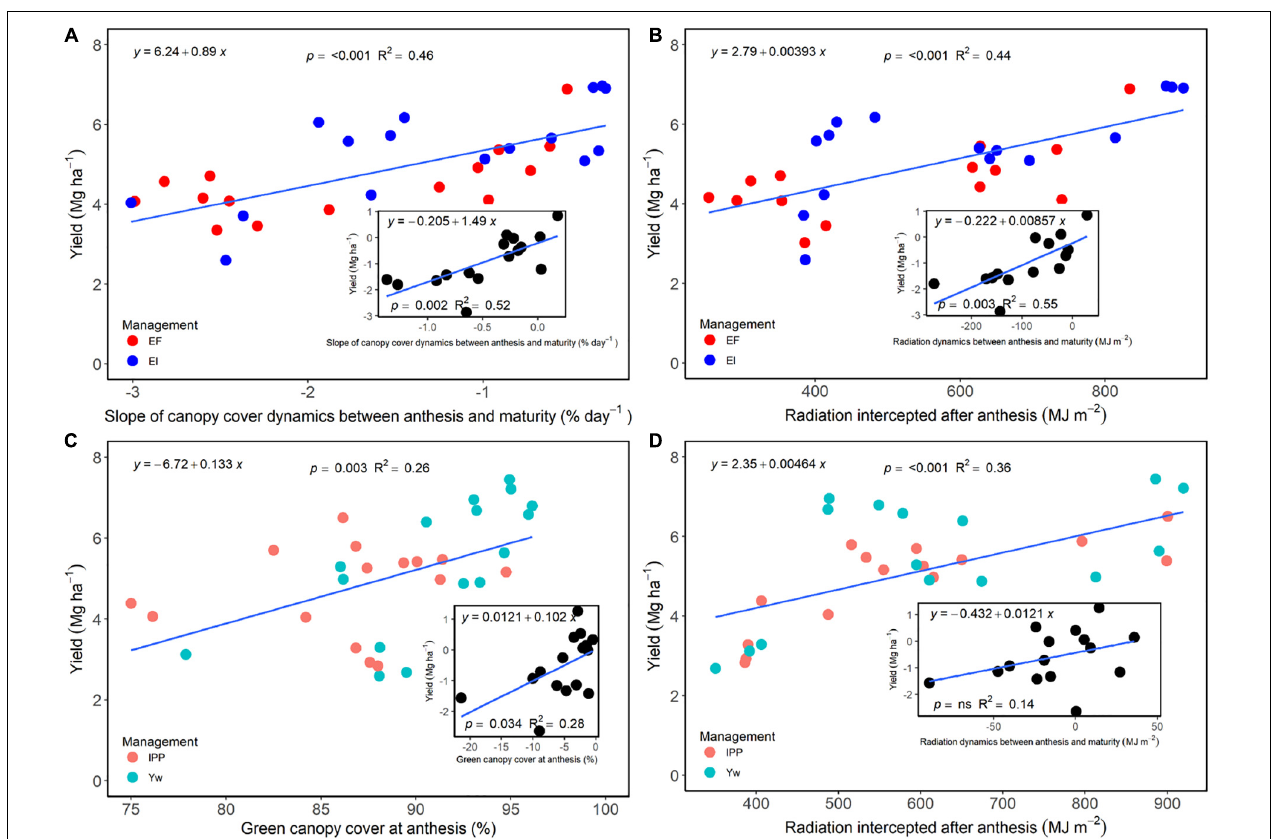
FIGURE 7 | (A) Relationship between wheat grain yield and a slope of the green canopy cover dynamics between anthesis and maturity for the enhanced fertility (EF) and ecological intensification (EI) treatments across genotypes and environments. The inset panel in (A) shows the relationship between the difference in both grain yield and a canopy cover dynamics slope between the two treatments. (B) Relationship between wheat grain yield and percent green canopy cover values measured at anthesis for the “yield potential” (Yw) and “increased plant productivity” (IPP) treatments across genotypes and environments. The inset panel (B) shows the relationship between the difference between IPP and Yw for grain yield and percent green canopy cover. (C) Relationship between wheat grain yield and radiation dynamics between anthesis and maturity for the EF and EI treatments across genotypes and environments. The inset panel in (C) shows the relationship between the difference in both grain yield and radiation dynamics between the two treatments. (D) Relationship between wheat grain yield and radiation values measured at anthesis for the Yw and IPP treatments across genotypes and environments. The inset panel (D) shows the relationship between the difference between IPP and Yw for grain yield and